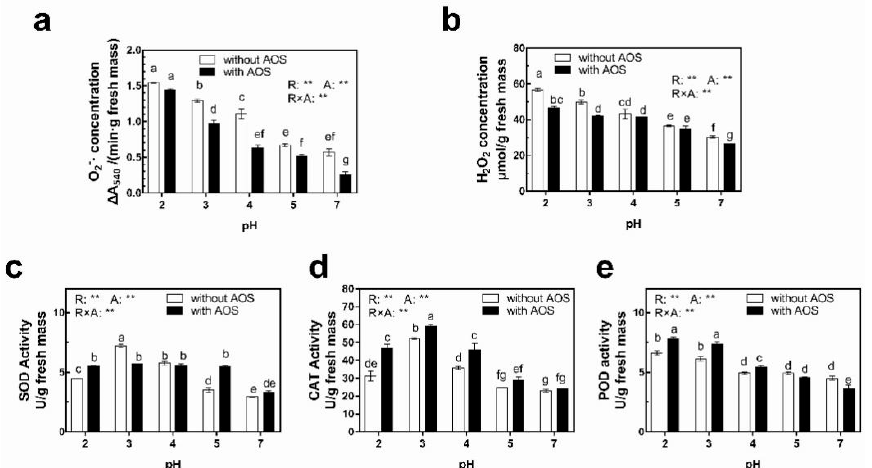
Figure 8. Effect of AOS in antioxidant enzyme activities and concentrations of reactive oxygen species and of leaves subjected to 7-day high temperature-low pH compound stress. ( a ) Superoxide anion (O 2 − · ) concentration. ( b ) Hydrogen peroxide (H 2 O 2 ) concentration. ( c ) Activity of superoxide dismutate (SOD). ( d ) Activity of peroxidase (POD). The columns with the same letter in each panel indicate an insignificant difference among different treatments ( p < 0.05).The p values of two-way ANOVA for rain pH (R), AOS (A) and their interaction (R × A) are shown: **, p ≤ 0.01; *, p ≤ 0.05; NS, p > 0.05.